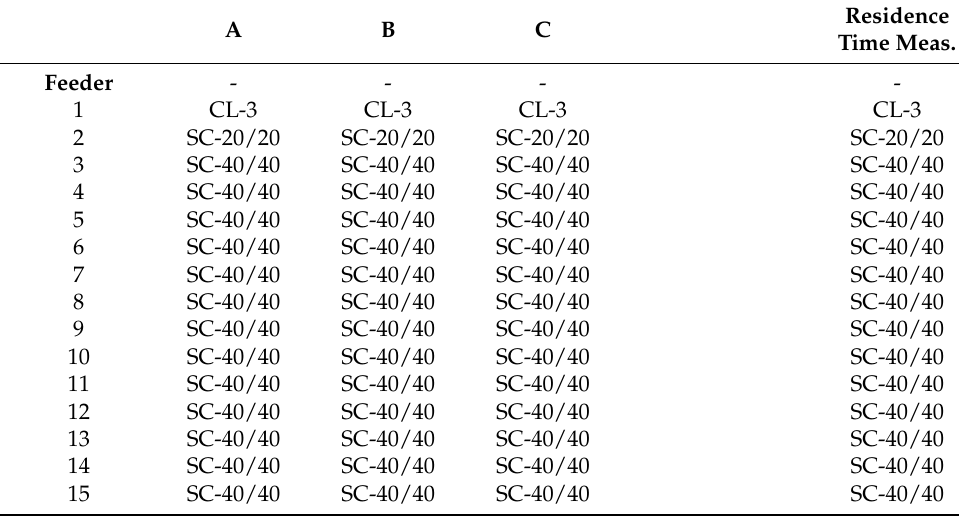
Table A2. The order of screw element’s code of screw configurations *. A B C